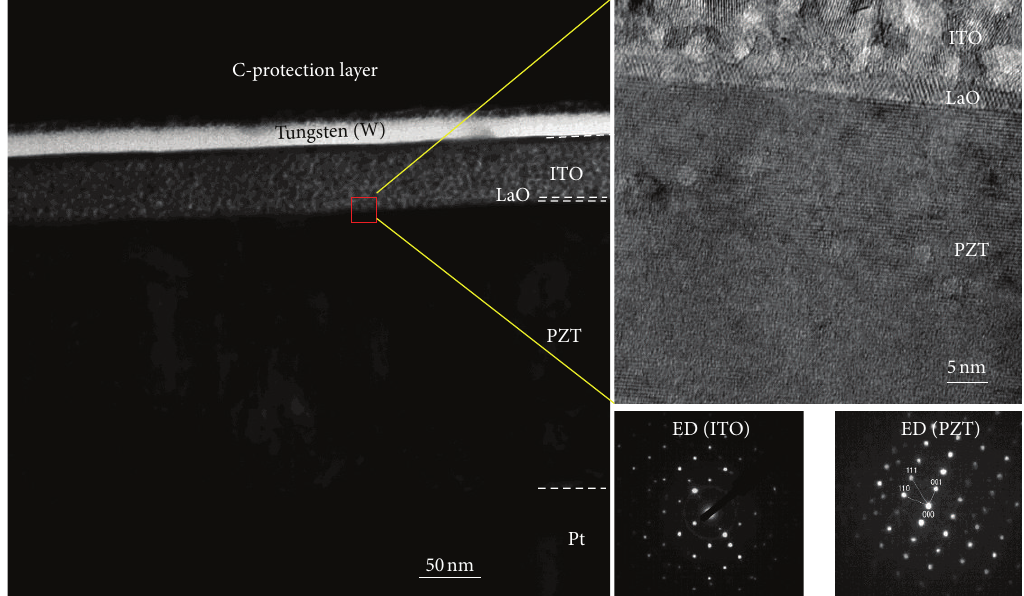
Figure 3: Cross-sectional HR-TEM images of the ITO/LO/PZT/PT stacked structure and electron diffraction patterns of ITO and PZT layers.